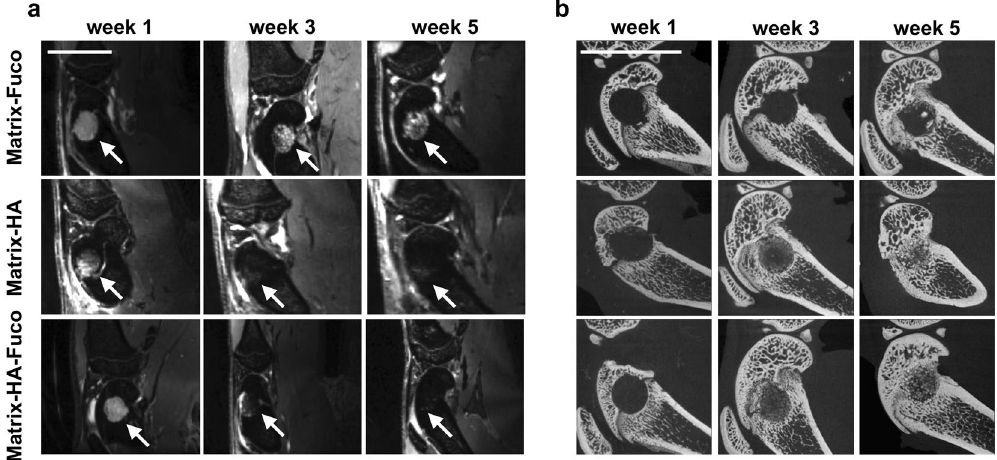
Figure 1. ( a ) 3D WS-bSSFP in vivo representative images and ( b ) representative 2D pictures of the median region of the ex vivo Micro-CT 3D reconstructed femoral condyles, 1, 3 and 5 weeks after implantation of Matrix-Fuco, Matrix-HA, and Matrix-HA-Fuco matrices (arrows). The number of samples used for both techniques is indicated in Tables 1 and 2, respectively. The MRI signal from defects filled with Matrix-HA and Matrix-HA-Fuco disappeared 5 weeks after implantation. At week 5, mineralization was visible within the defect site for these latter conditions. Scale bar represents 1 cm.